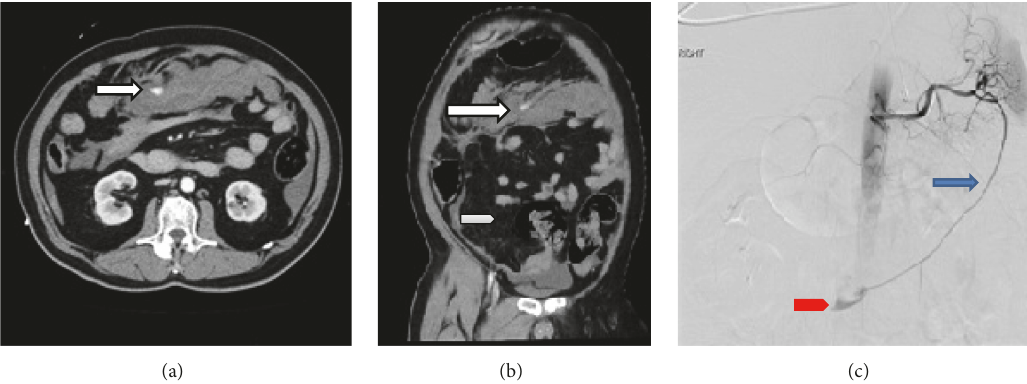
Figure 1: Case 1: Figures 1(a), 1(b), and 1(c). (a) Axial CT scan showing active contrast extravasation in the region of greater omentum. (b) Coronal MIP image showing actively bleeding aberrant artery arising from the splenic artery (arrow) and extending diagonally into the right iliac fossa, supplying the fat containing lesion (arrow head ). (c) Pre-embolization angiogram depicting the aberrant artery (blue arrow ). There is active contrast extravasation inferiorly (red arrow head ).